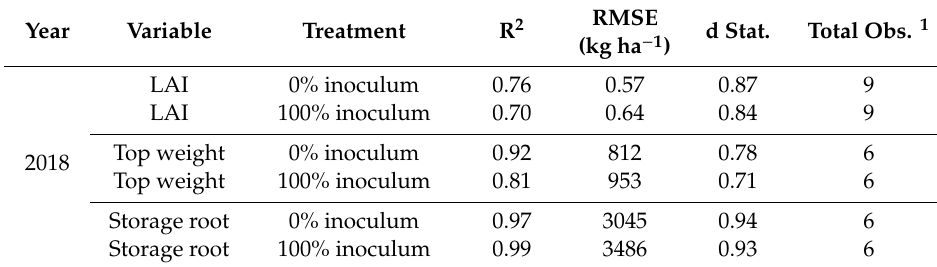
Table 7. Detailed statistics for simulated and observed values of LAI (m 2 m − 2 ), top weight